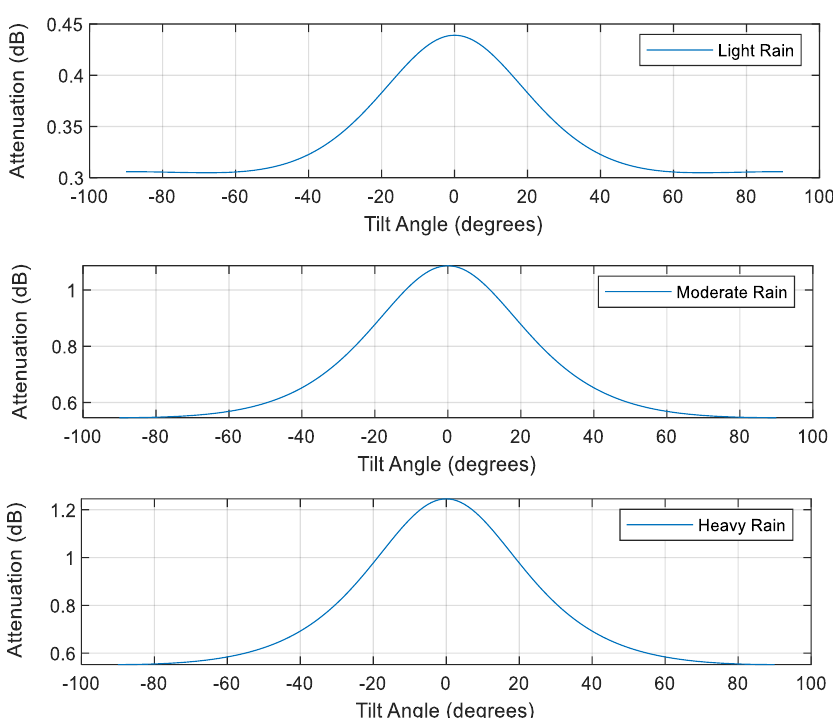
Figure 8. Rain attenuation plot versus tilt angle and rainfall depth levels.